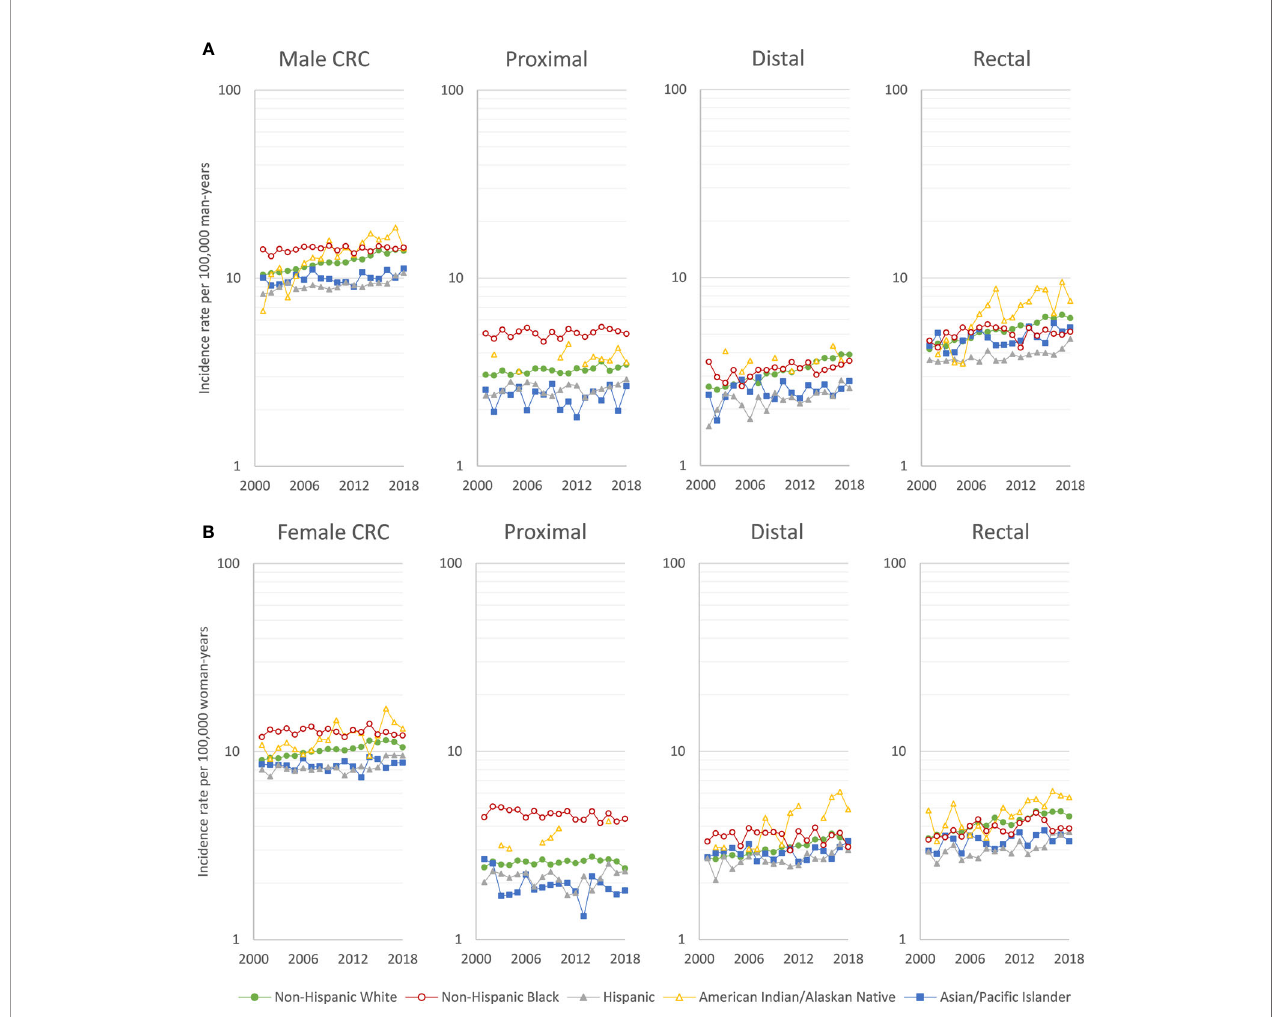
FIGURE 1 | Age-adjusted early-onset (20-49 years of age) colorectal cancer incidence rates per 100,000 person-years in (A) men and (B) women, US Cancer Statistics